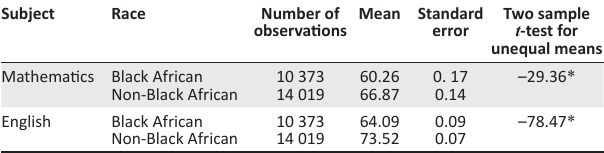
TABLE 10: Two sample test results comparing the Mathematics and English results of Black African with non-Black African students (assuming unequal variances in the grouped